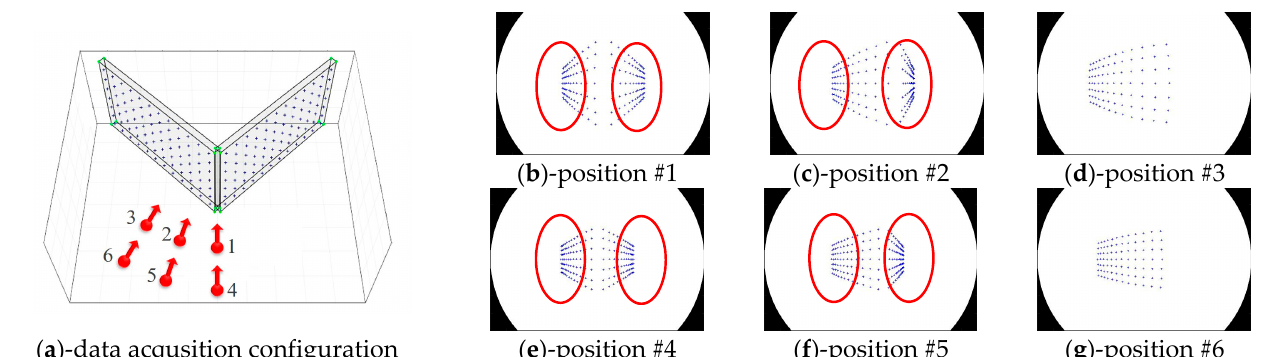
Figure 7. Distributions of image points in case of V-type test-bed (equidistant).